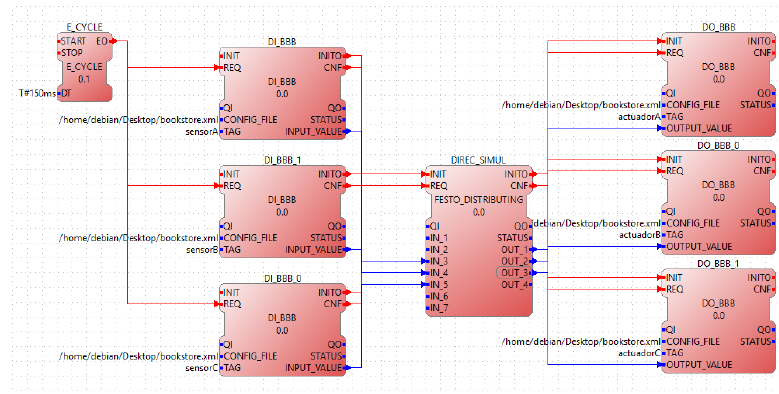
Figure 14. Distributing application under IEC 61499 for batch